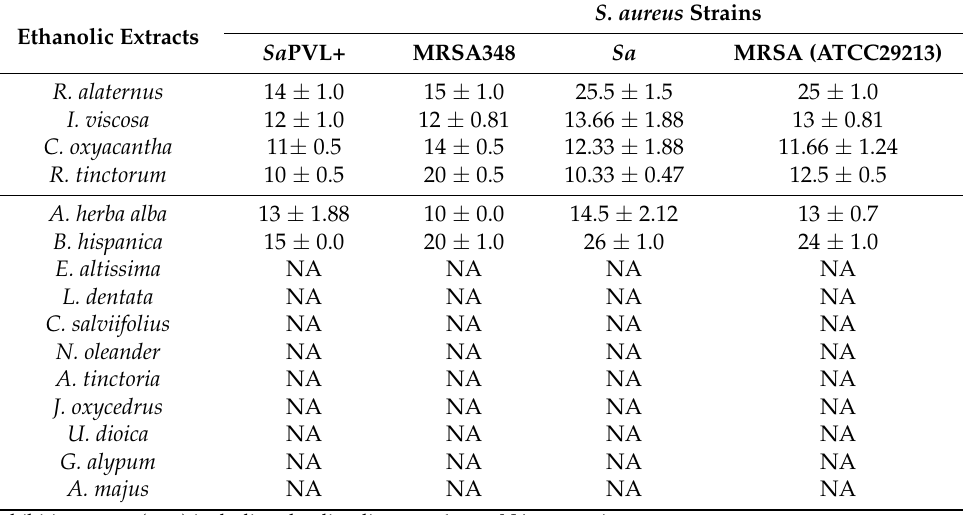
Table 1. Inhibition zones of ethanolic extracts of the fifteen plants against S. aureus strains.